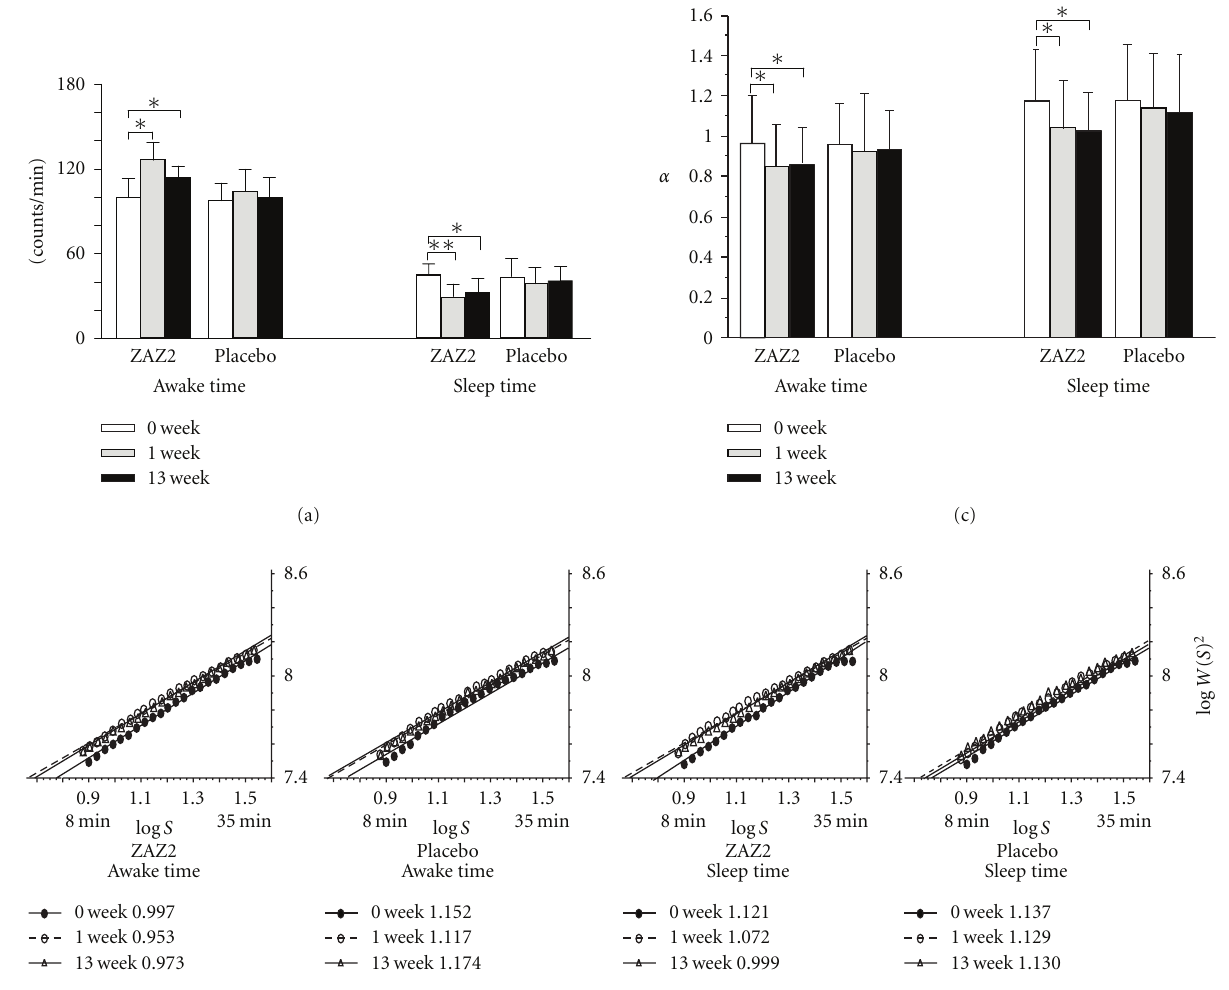
Figure 2: Before and after administration of granules of ZAZ2 and placebo for mean counts of physical activity (a), average wavelet coe ffi cients, as a function of the wavelet scale for awake time and sleep-time, the slopes are power-law exponents, α (b), and comparisons of the mean α